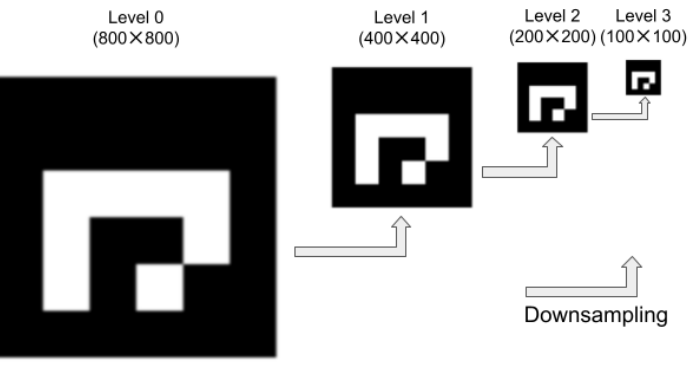
Figure 6. Gaussian Pyramid Reconstruction with 3 levels for the ArUco marker (ID =